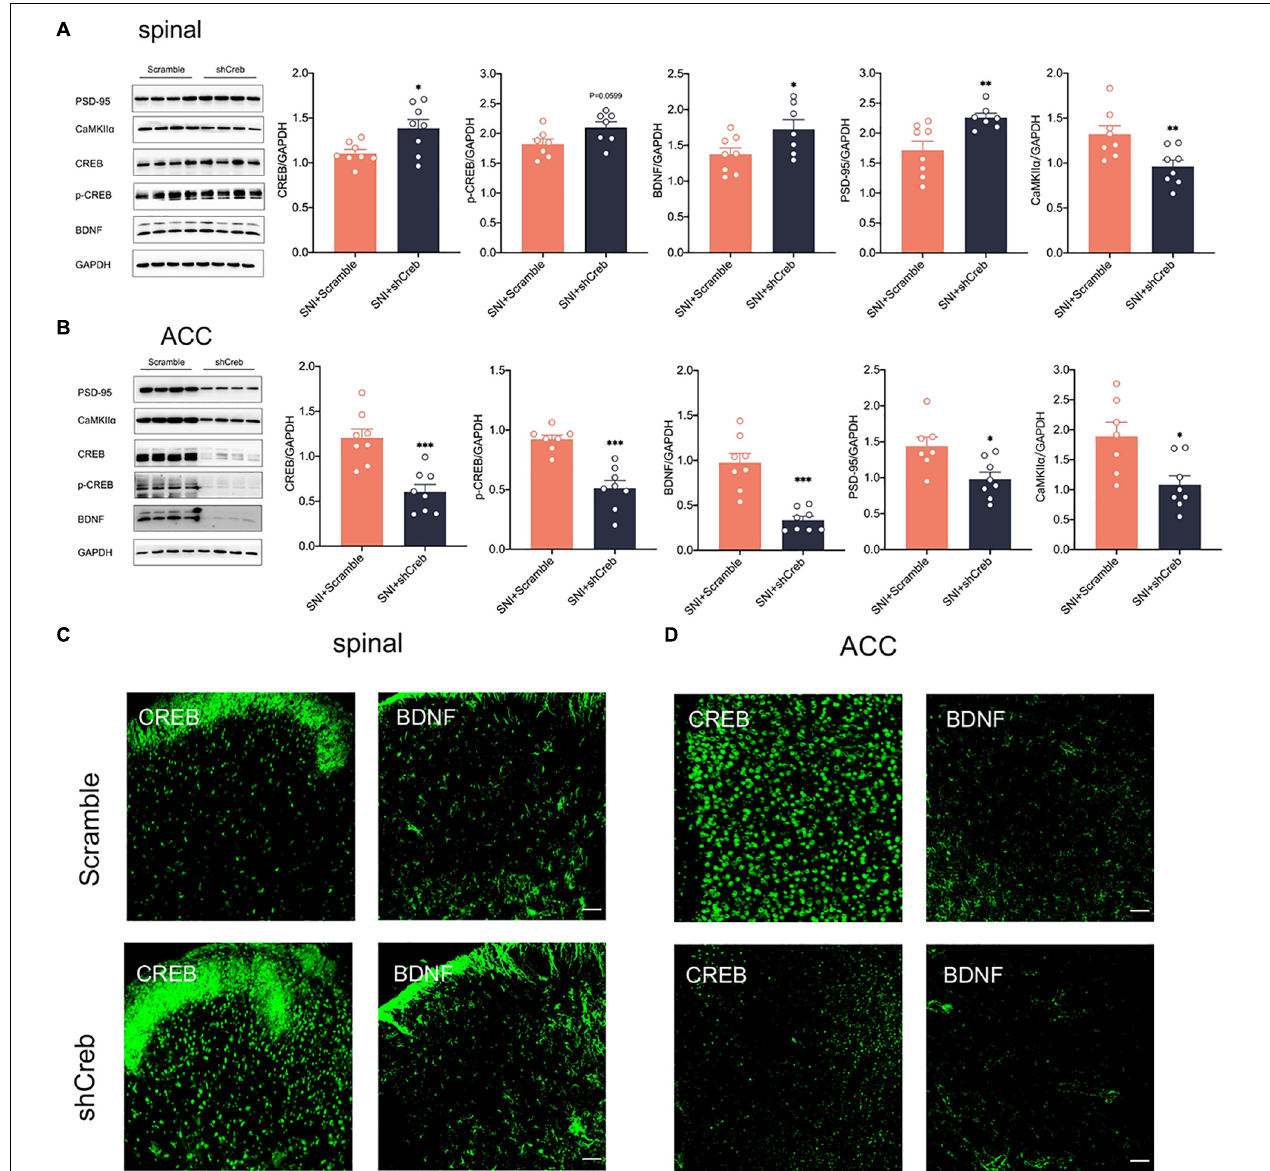
FIGURE 7 | Knockdown of CREB in the ACC increased CREB/BDNF expression in the spinal cord in SNI rats. (A) Knockdown of CREB in the ACC activated the CREB/BDNF pathway in the spinal cord ( n = 8 rats/group). (B) Knockdown of CREB in the ACC inhibited the CREB/BDNF pathway in the ACC ( n = 8 rats/group). (C) Representative examples showing that knockdown of CREB in the ACC increased the expression of CREB and BDNF in the spinal cord (Scar bar = 50 µ m). (D) Representative examples showing that knockdown of CREB in the ACC decreased the expression of CREB and BDNF in the ACC (Scar bar = 50 µ m). ∗ P < 0.05, ∗∗ P < 0.001, ∗∗∗ P < 0.0001 for SNI + Scramble vs. SNI +